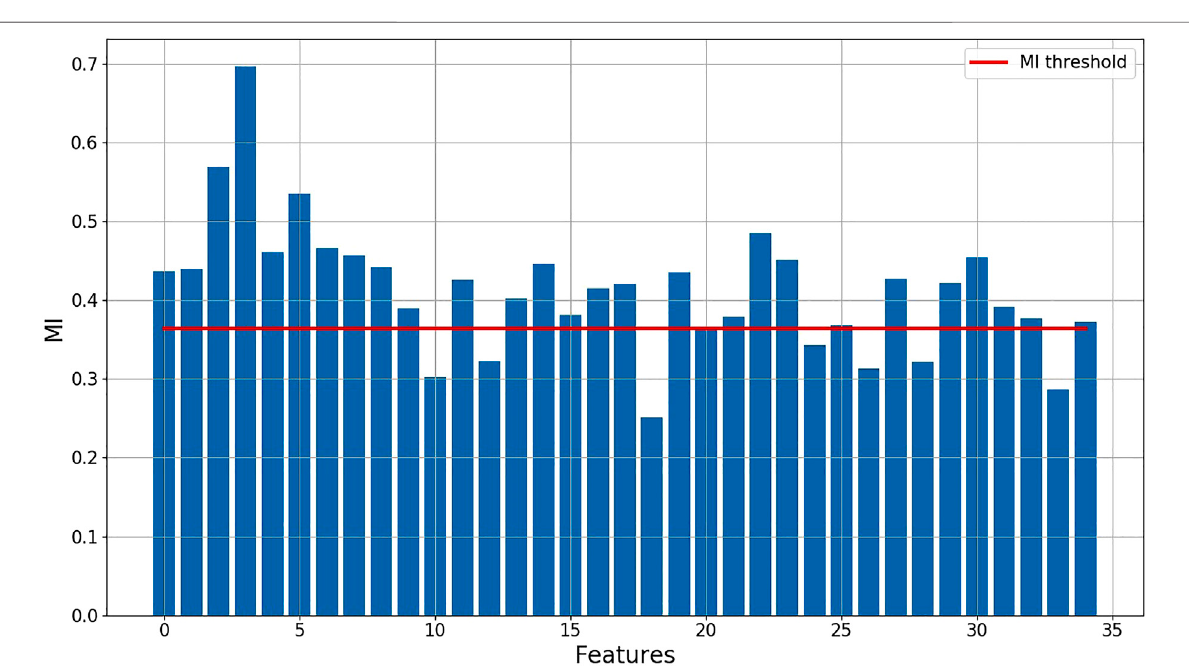
Frontiers in Chemical Engineering |